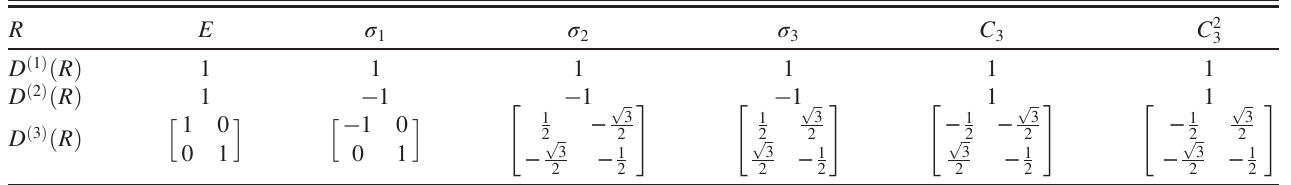
TABLE I. Irreducible representations for S 3